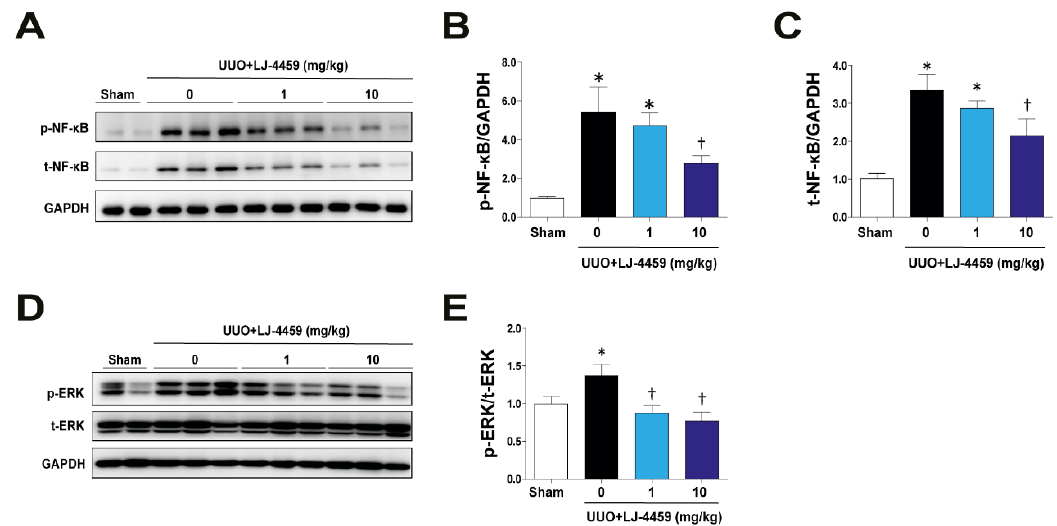
Figure 6. LJ-4459 downregulates ERK and NF- κ B phosphorylation. ( A–E ) Immunoblotting analysis of NF- κ B and ERK phosphorylation in the kidney. The levels of proteins were normalized with GAPDH or their respective total protein. Data are presented as mean ± SE of 7–8 mice. * p < 0.05 vs. sham mice, † p < 0.05 vs. UUO mice.